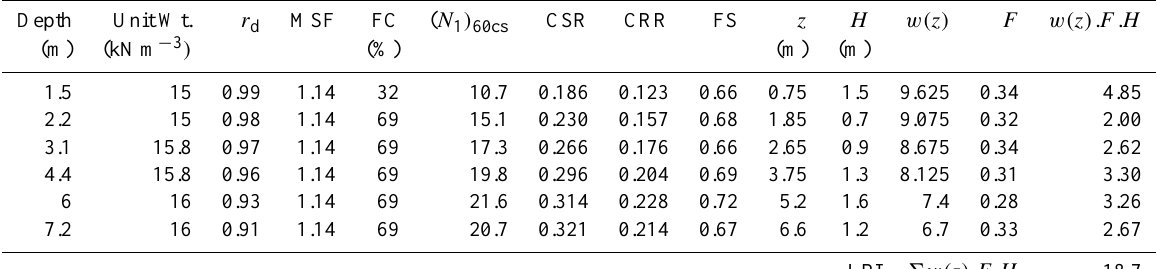
Table 5. Computation of LPI for PGA 0.3 g corresponding to M w = 7.0. Depth Unit Wt. r d MSF FC ( N 1 )